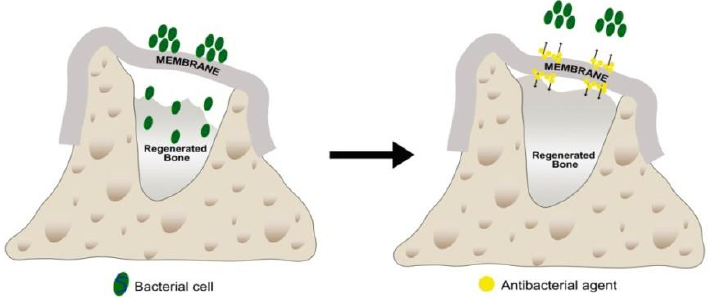
Figure 1. A barrier membrane employed to avoid soft tissue cell invasion, enhancing space mainte- nance of the regenerating area. The incorporation of antibacterials in the membrane has been sug- gested to inhibit bacterial contamination during the surgical intervention or the healing period if membrane exposure to the oral cavity occurs, improving the performance of the bone regeneration procedure.